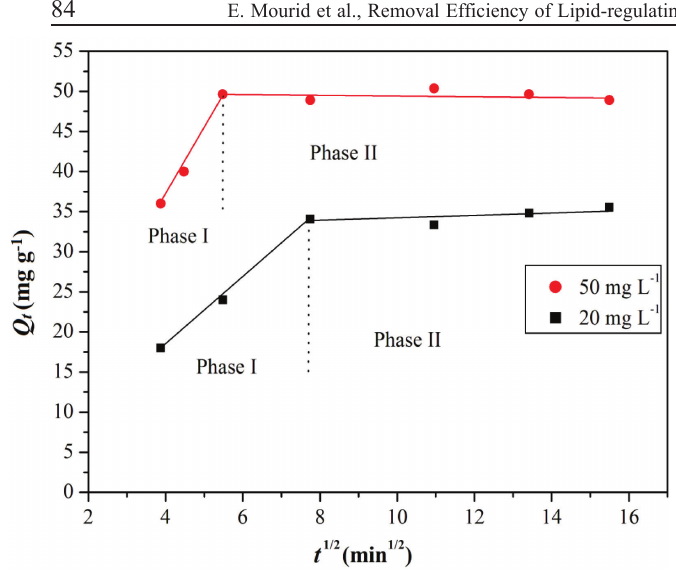
Fig. 4 – Linear representation of the kinetic model of intra- particle diffusion for CA